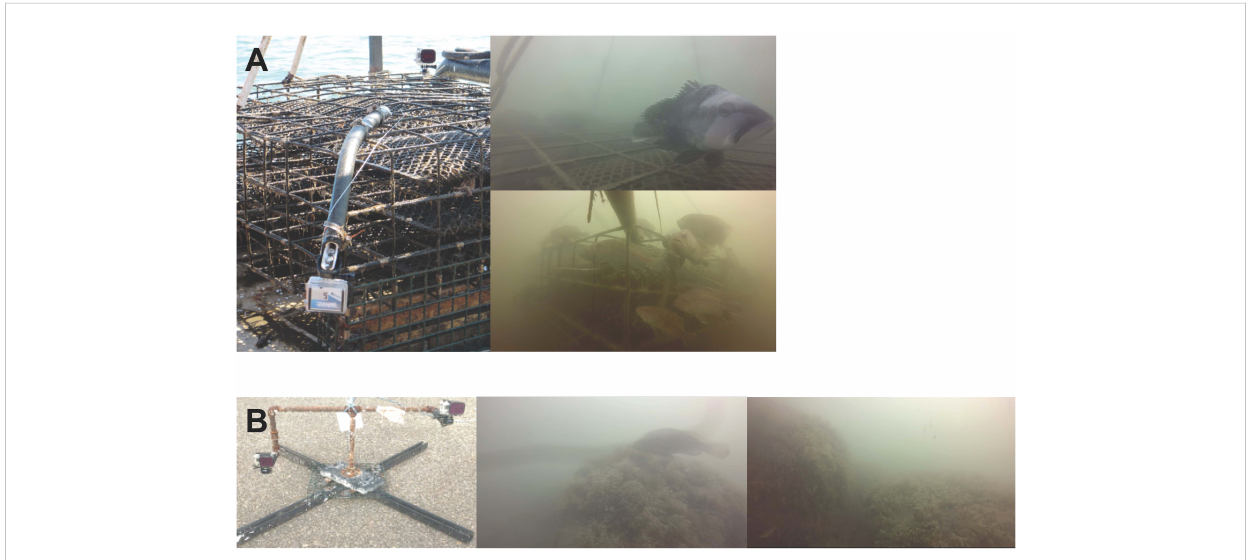
FIGURE 2 Photographs of camera placements on cages and T-platform stands, and the corresponding views provided by each camera. (A) Cameras were attached to cages that provided perspective across the top of the cage surface, down two sides of the cage, and the cage-sea fl oor interface. (B) Cameras were deployed adjacent to boulders using a minimal-structure “ T-platform ” stand that provided perspective across the boulder top, side, and boulder-sea fl oor